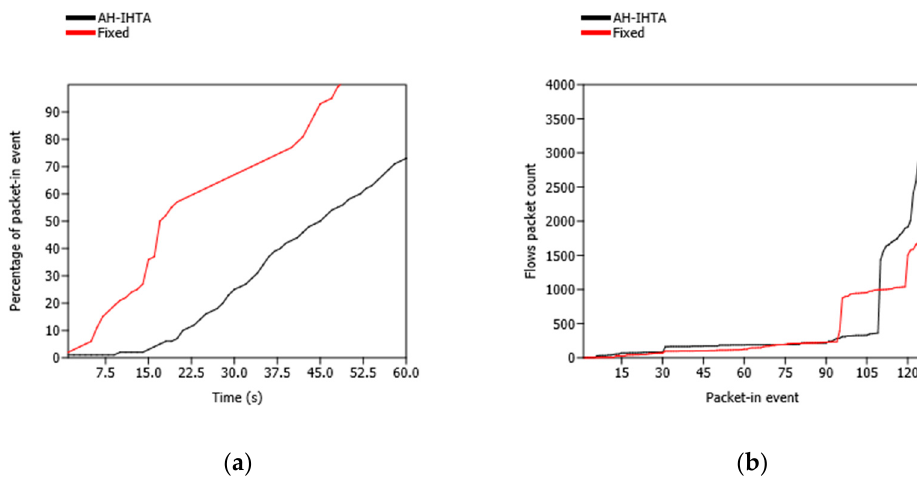
Figure 8. Results of the idle and hard timeout with di ff erent flow table size. ( a ) Percentage of packet-in event with respect to time (s). ( b ) Flows packet count with respect to packet-in